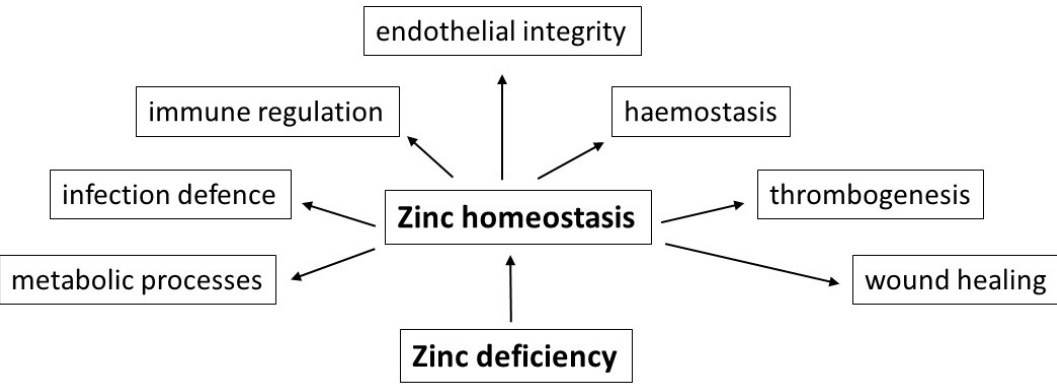
Figure 1. Schematic representation of important functional effects of a balanced zinc homeostasis in the context of food-induced zinc deficiency as possible risk factor for the development of haemorrhagic strokes.